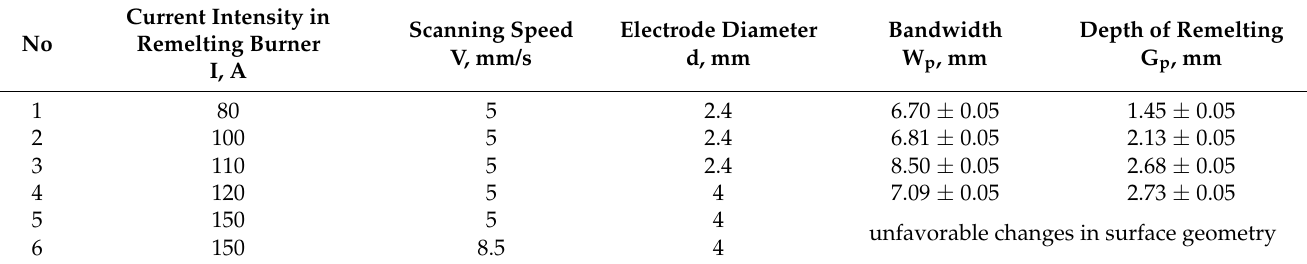
Table 2. GTAW remelting